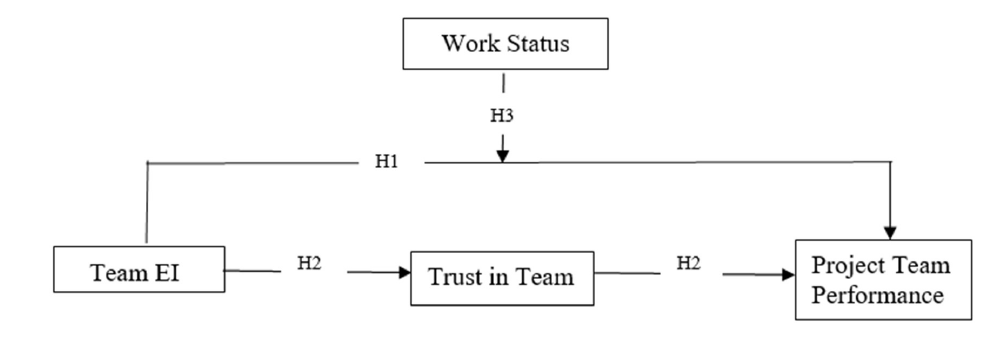
Fig. 1: Proposed research